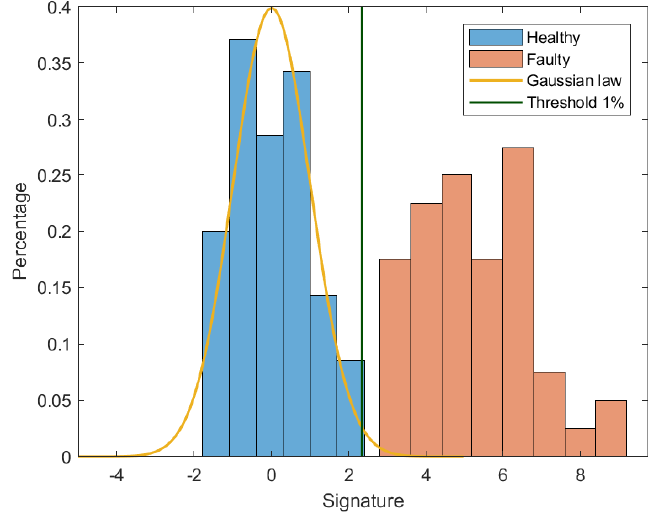
Figure 13. Histogram distribution of fault signatures using 1